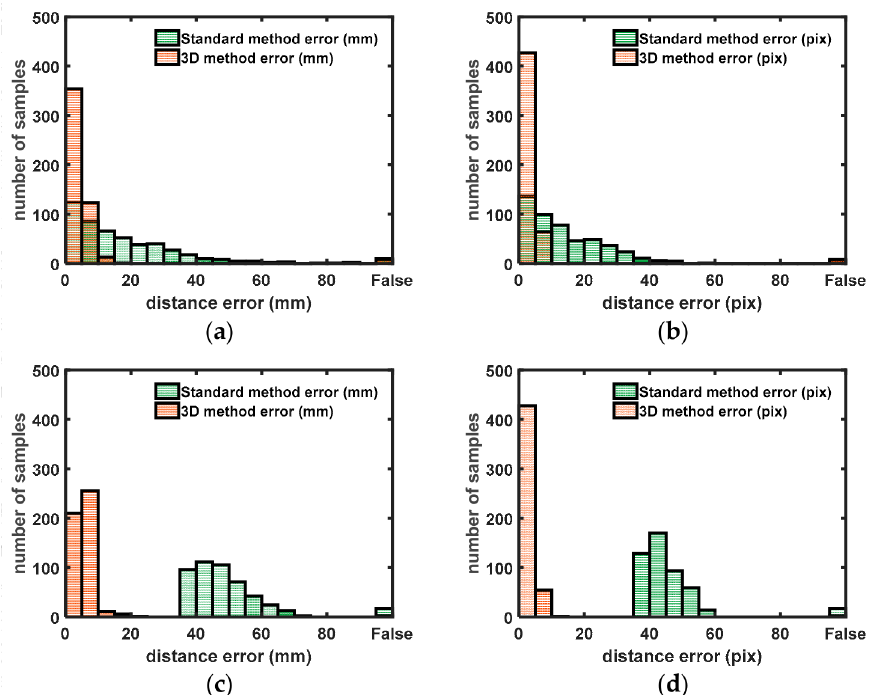
Figure 10. Histograms containing the difference between the measured laser spot and the input laser spot. “False” values are laser spots that are not detected (out of search range). ( a , b ) Distance errors (pixel, mm) when the barrel was not moved after (2D) calibration. ( c , d ) Distance errors (pixel, mm) when the barrel was moved 1 m away from the original